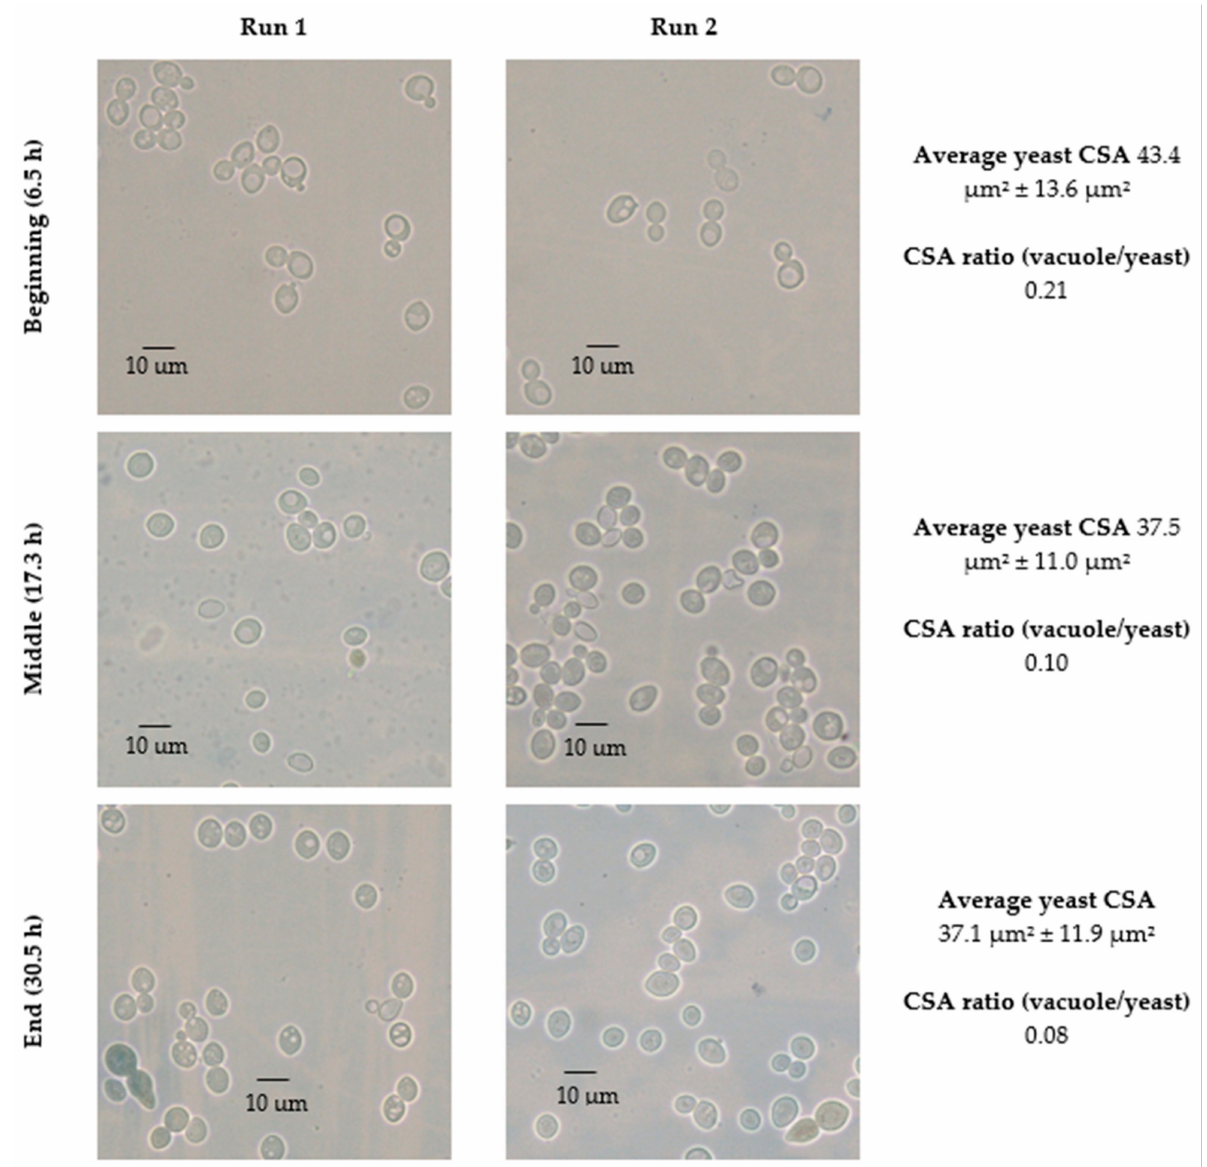
Figure 5. Bright-field microscopic image of yeast cells (1000 × magnification) of the duplicate runs from beginning, middle and end of the fermentation processes at 30 ◦ C. The media included 0.01% w/v methylene blue solution to differentiate non-viable cells from the analysis. The yeast CSA and CSA ratio (vacuole to yeast area) were determined manually using the Nikon